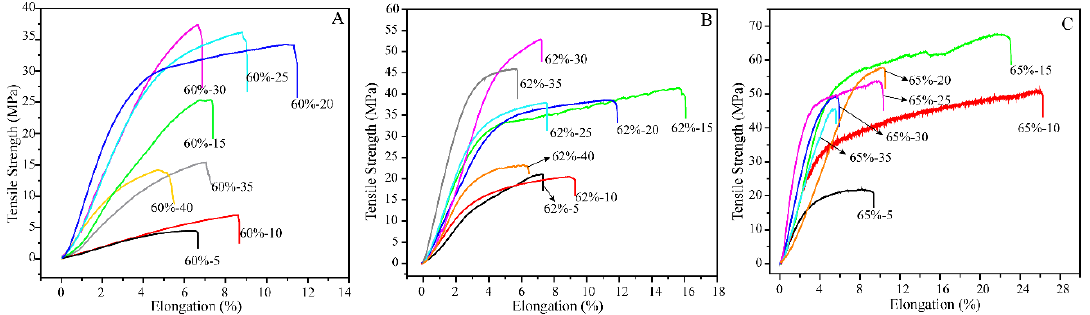
Figure 6. Tensile strain curves of cellulose films regenerated in 60 wt % ( A ), 62 wt % ( B ) and 65 wt % ( C ) LiBr molten salt hydrate with different dissolving time. Table 3. Mechanical properties of cellulose films prepared under different conditions.